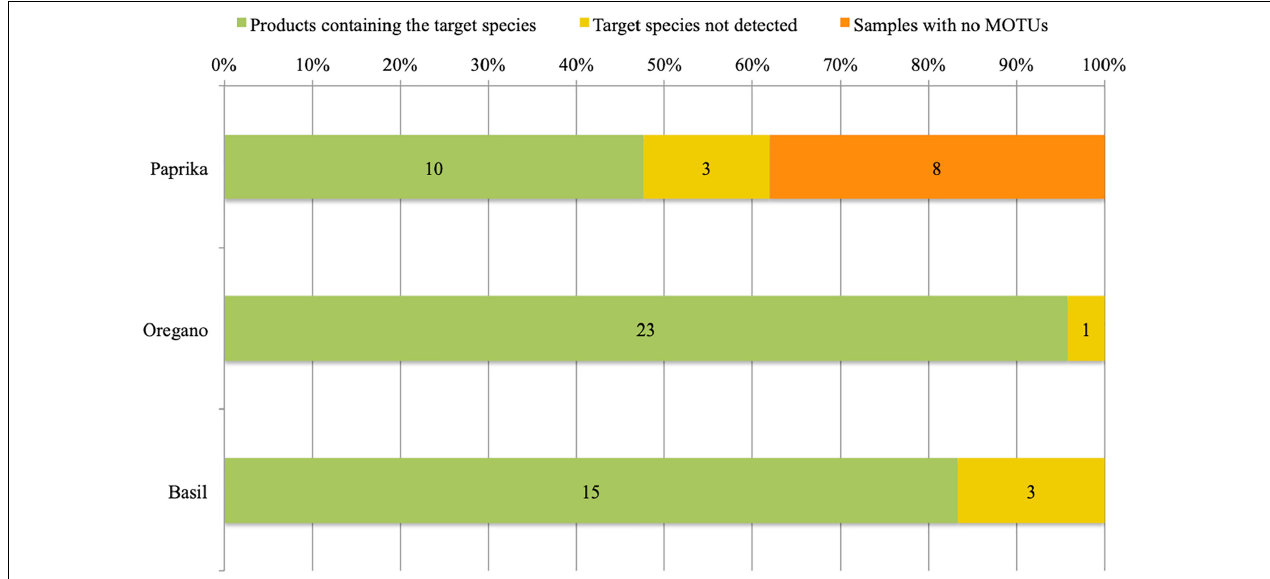
FIGURE 1 | Product fidelity rates per target species using DNA metabarcoding based